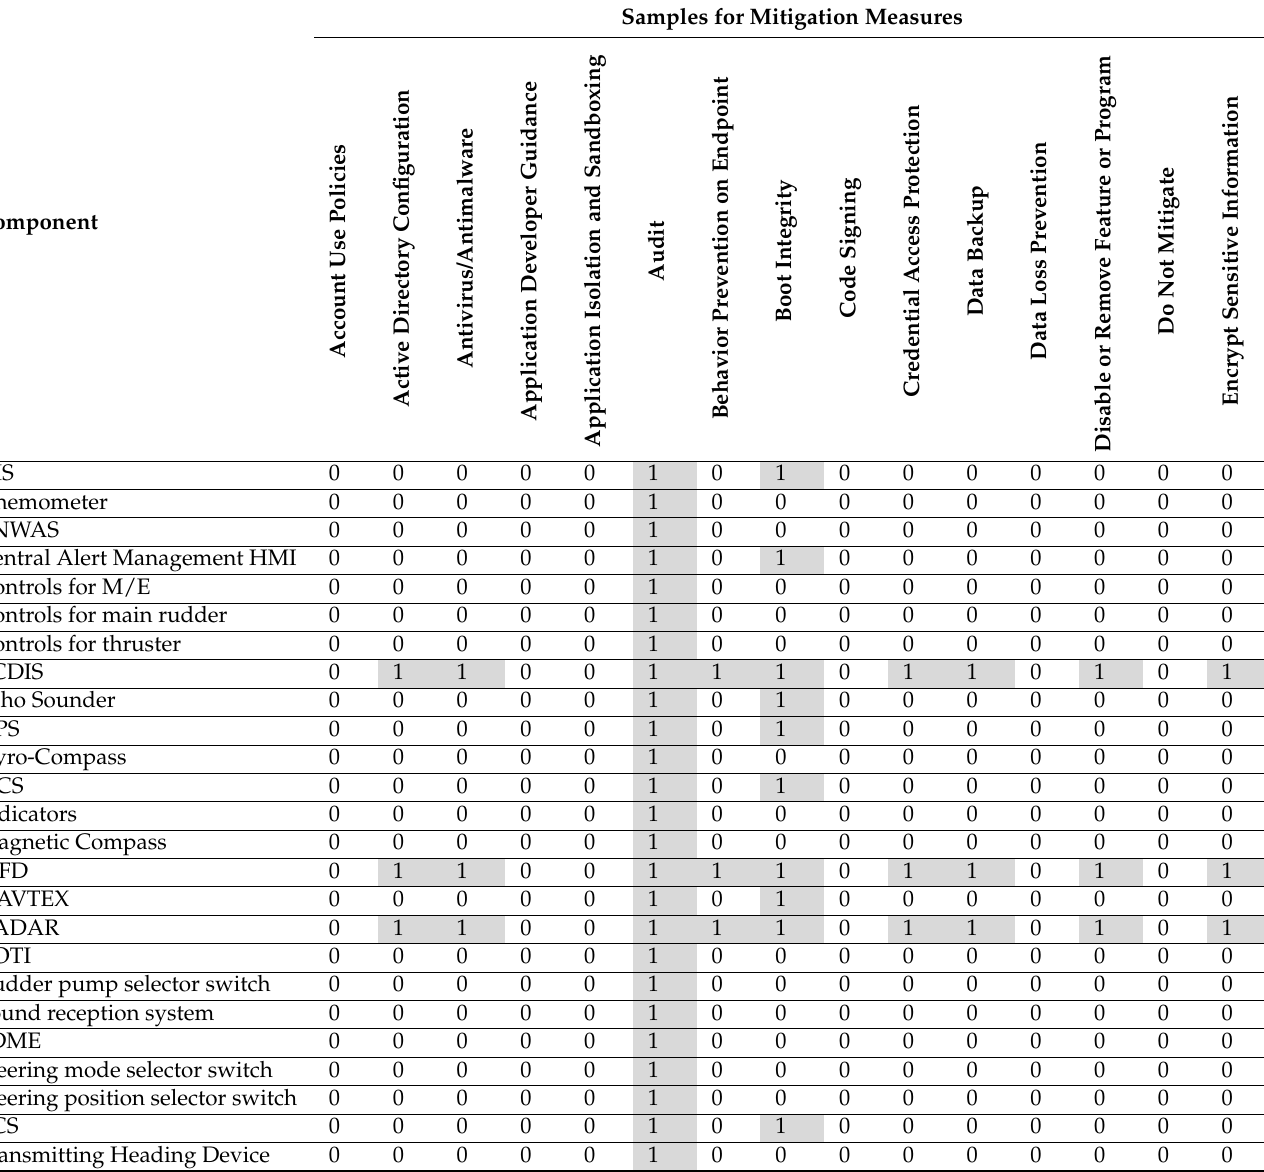
Table 9. Samples for risk-mitigation